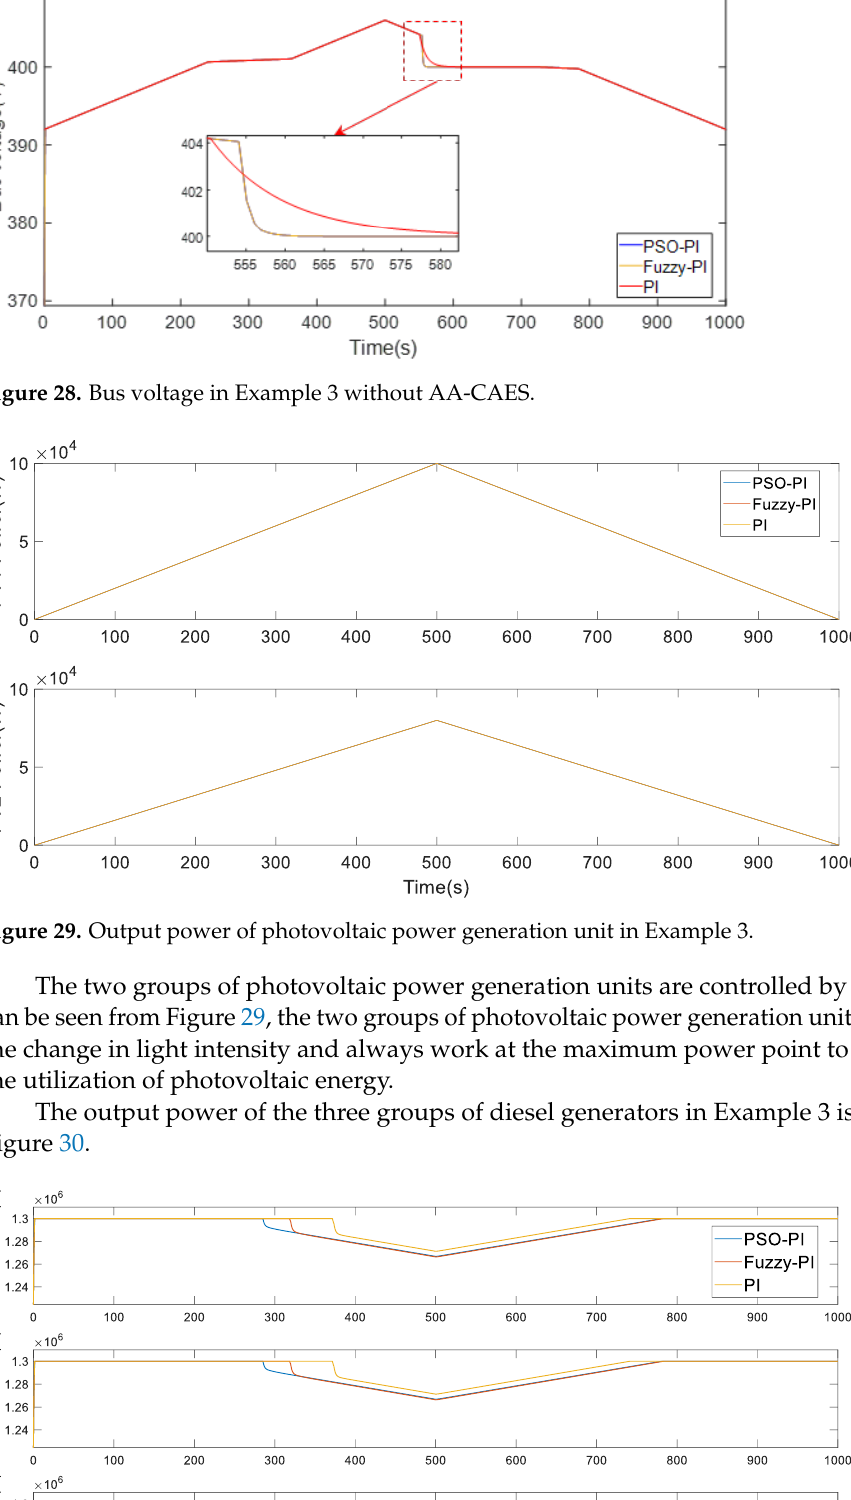
Figure 30. Output power of diesel generator in Example 3.